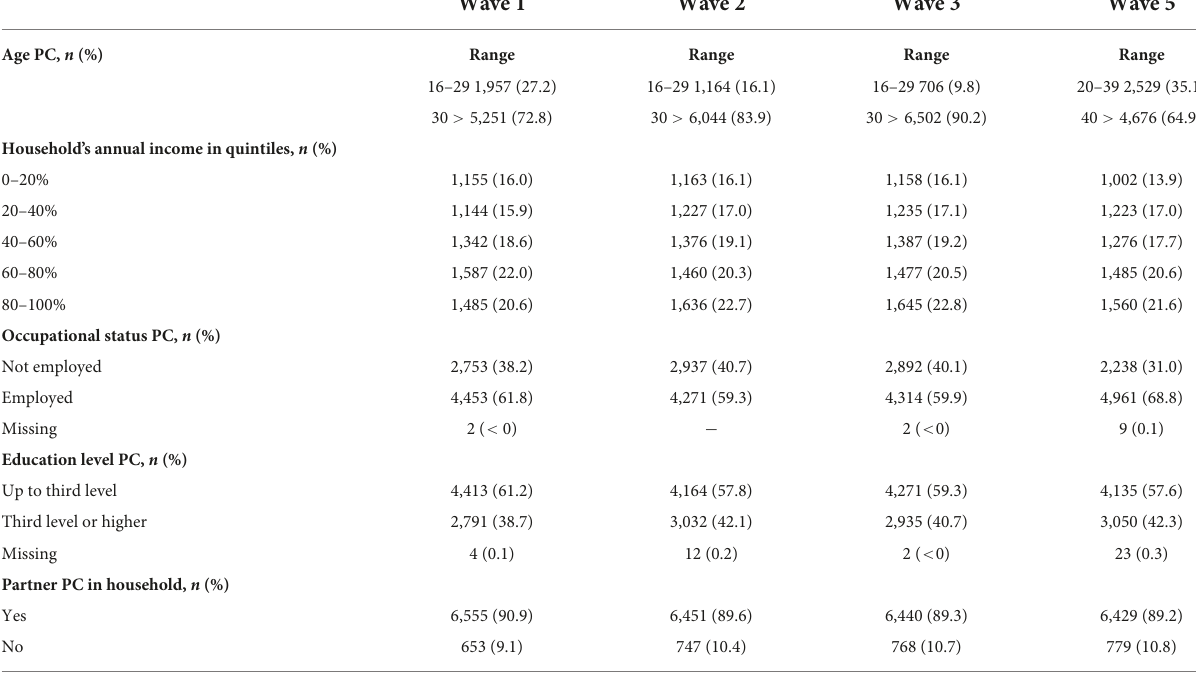
TABLE 2 Demographics and background information of the primary caregiver and the child across the 4 waves. Wave 1 Wave 2 Wave 3 Wave 5